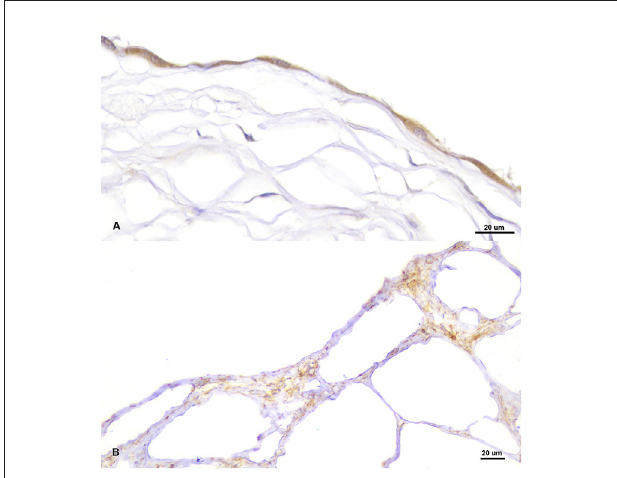
FIGURE 3 | Positive immunolabelling for pan-endothelial marker factor VIII-related antigen in the endothelial cells lining the cystic cavities (A) and for smooth muscle actin ( α -SMA) in the septum that separate the cysts (B)